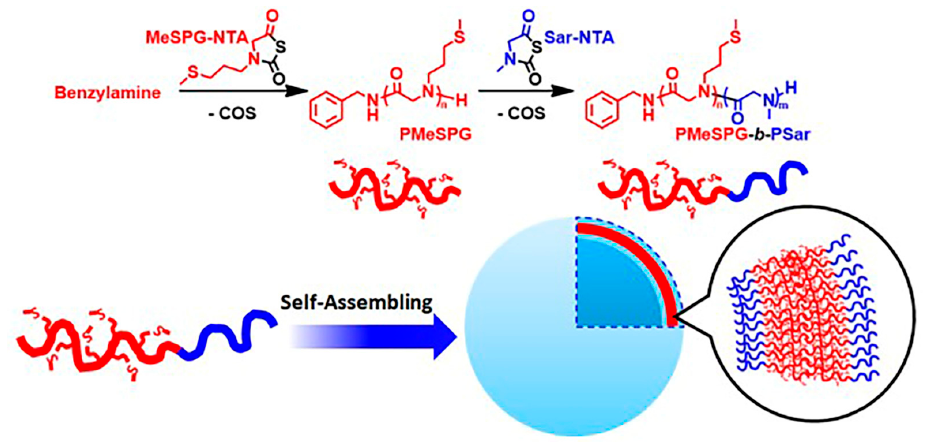
Figure 13. Synthesis of PMeSPG-b-PSar block copolymers and their self-assembly. Reprinted with permission from [103] . Copyright 2019, American Chemical Society.